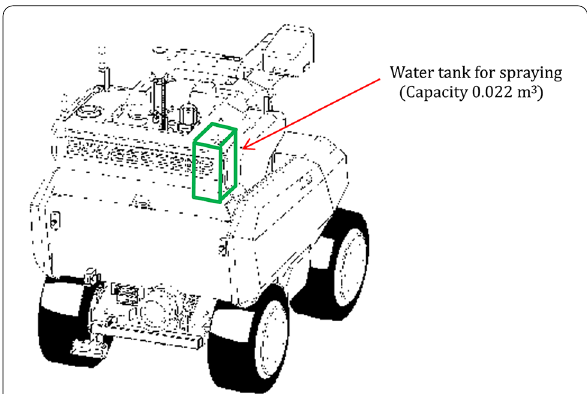
Fig. 17 Position diagram of the water